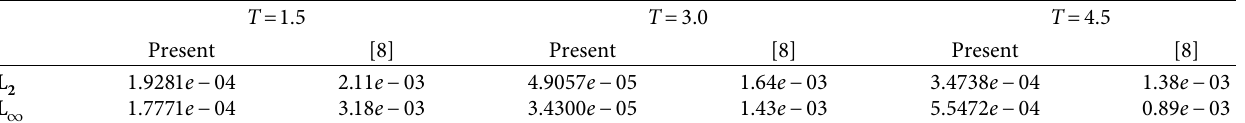
Table 2: Errors of Burgers’ equation at diferent time levels for the frst test problem.